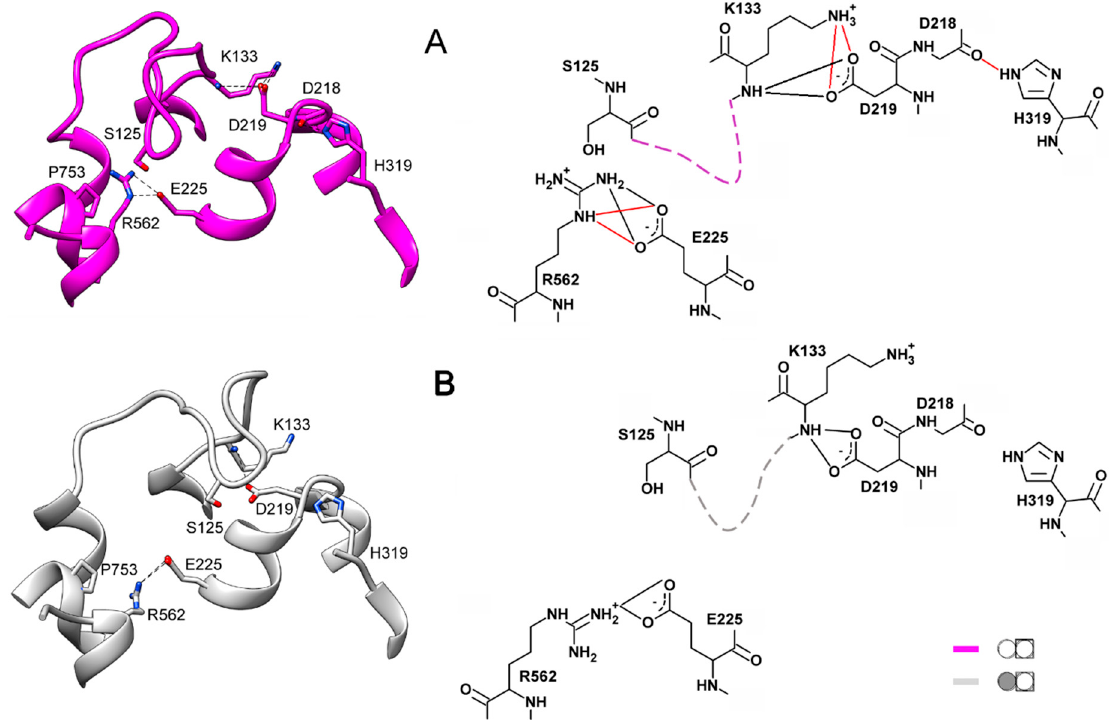
Figure 6. External H-bonds stabilizing the two conformations of loop 2–3 in IDP-free subunits. Loop 2–3 is shown schematically by dashed lines on the right images. The main colors correspond to the color scheme defined in Figure 5. ( A ) Subunit B of IDP-free dimer. ( B ) IDP-free subunit B; its neighboring subunit contains IDP. The H-bonds depicted in red in the right part of panel A are those disrupted in the structure shown in panel B.